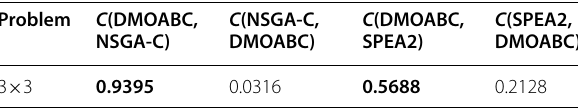
Table 10 C -metric comparison for DMOABC, NSGA-II, and SPEA2 The optimal values are set in bold font among these three